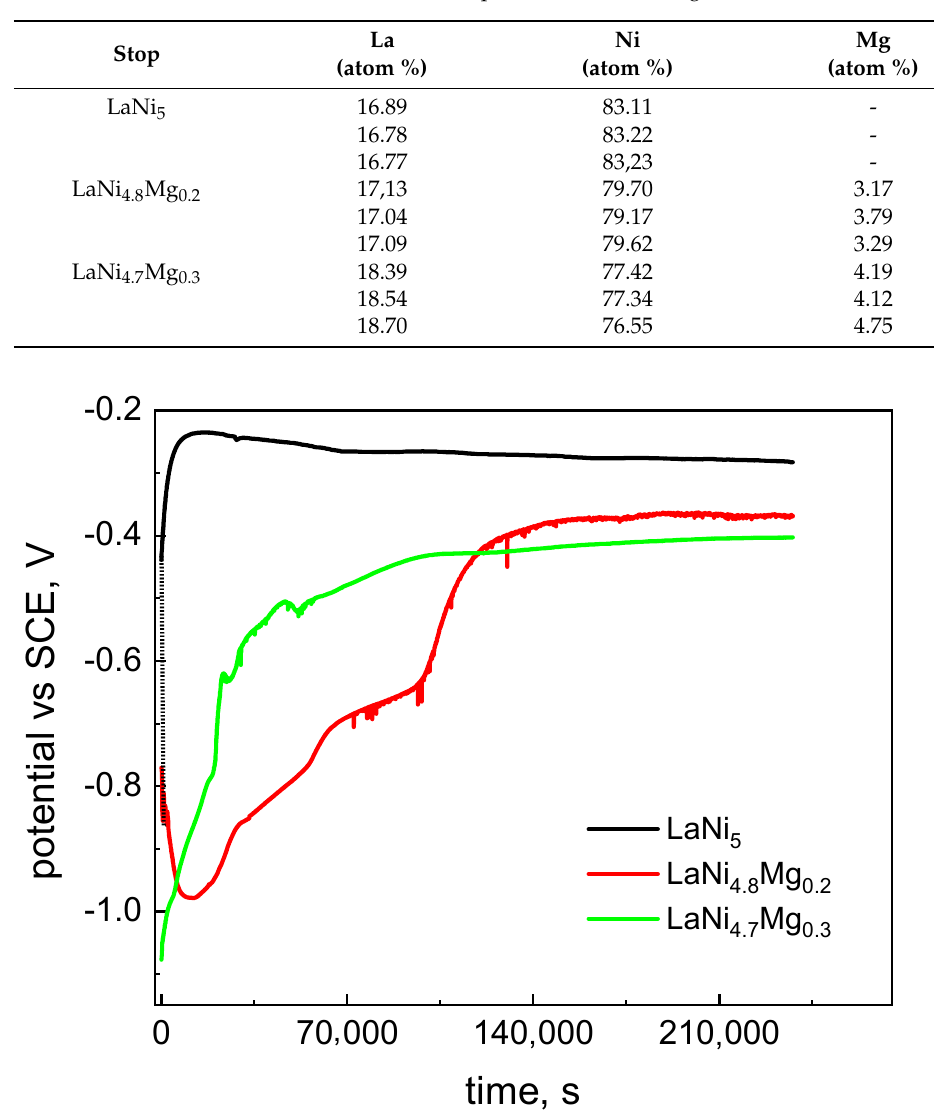
Figure 2. OCP changes for LaNi 5-x Mg x alloys (x = 0, 0.2, and 0.3) recorded for 66 h.